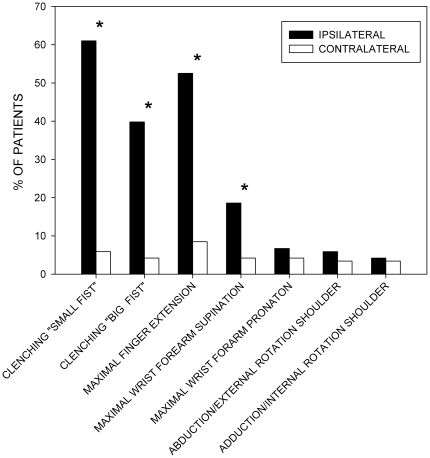
Impairment of hand motor function.Bars display the percentage of patients displaying the respective motor impairment. Significance: * p<0.001 ipsilateral vs. contralateral hand, Wilcoxon signed ranks method test.